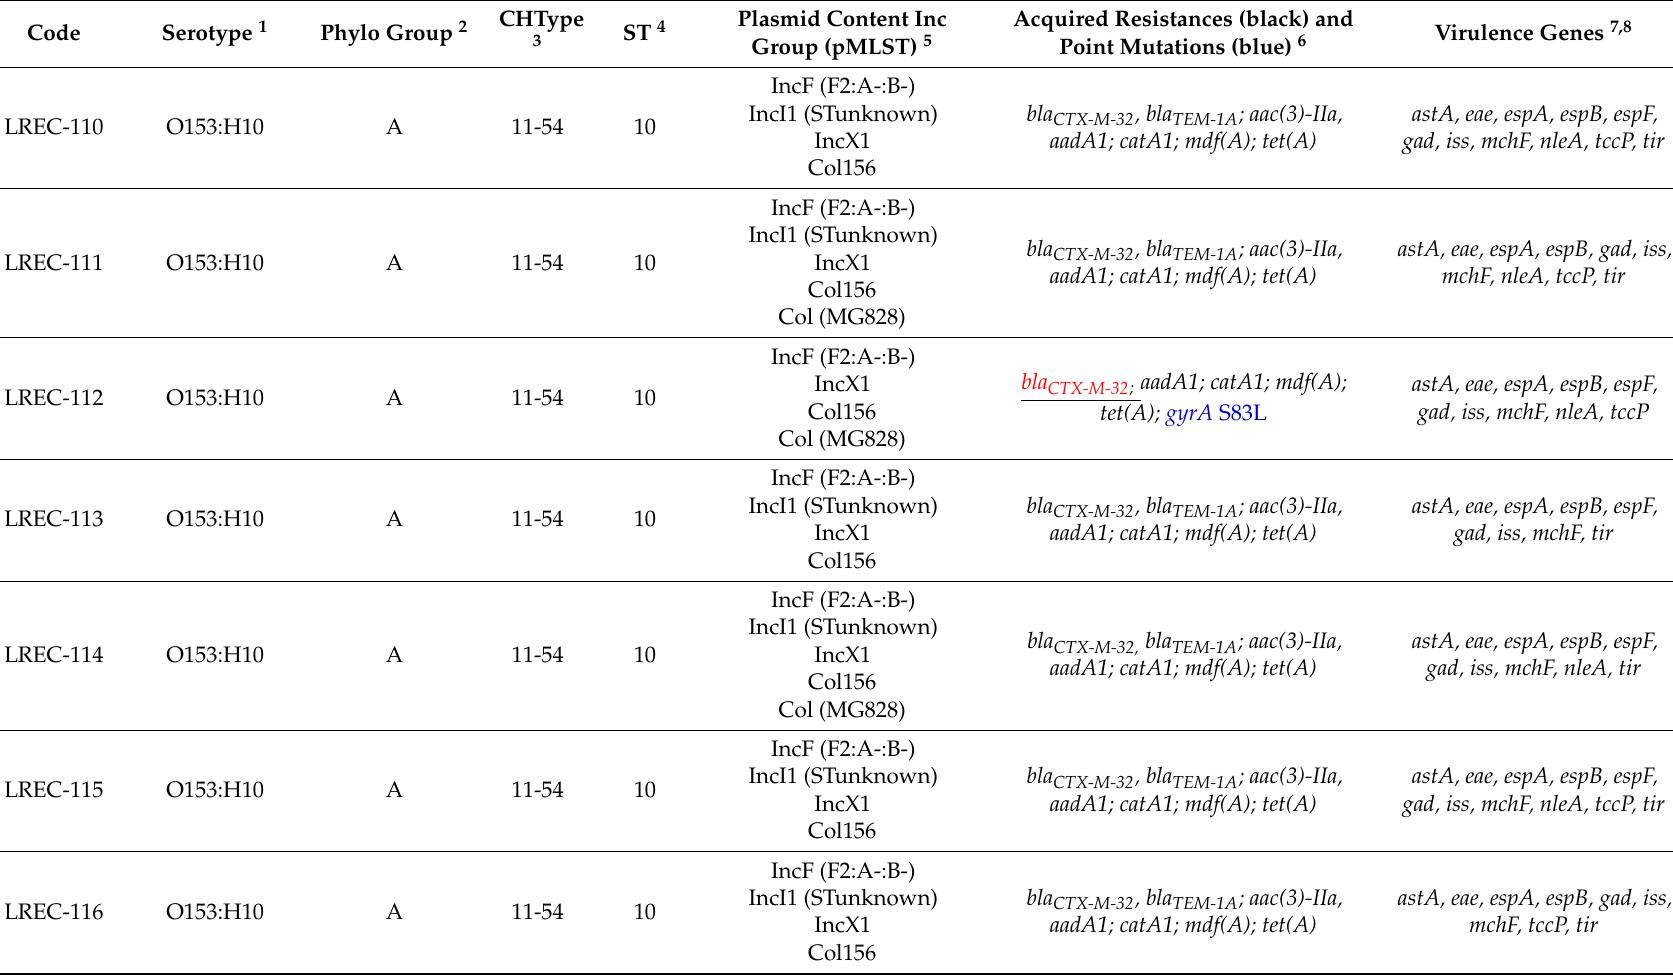
Table 2. In silico characterization of 17 Escherichia coli genomes from the study collection using Center for Genomic Epidemiology (CGE) databases and ClermonTyping (in red, results obtained only by conventional